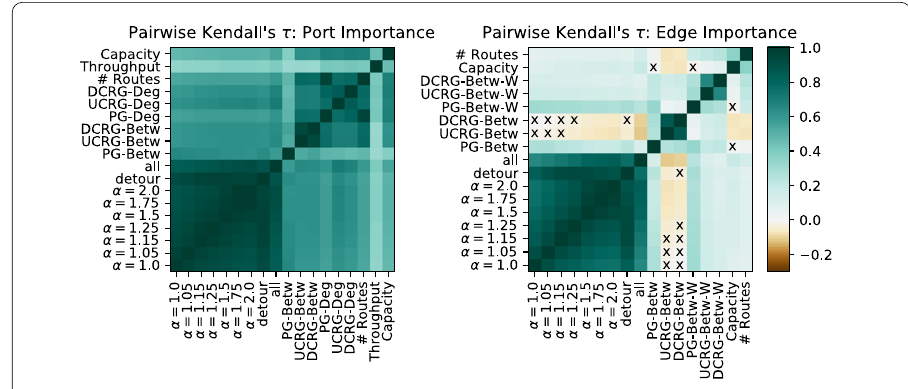
Figure 10 Pairwise Kendall’s τ rank correlation for port rankings between all importance measures for nodes (left) and edges (right). “Capacity” means ranking by the sum of TEU capacity of all routes where a node or edge appears; “# Routes” means ranking by the total number of routes in which the node or edge appears at least once; and “Throughput” means ranking the top 100 ports by container throughput. “DCRG” means directed co-route graph, “UCRG” means undirected co-route graph, and “betw” corresponds to betweenness and “deg” to degree. “all” refers to the full set of minimum-route paths without filtering and “detour” refers to detour factor filtering. Route node and edge betweenness measures correlate strongly across all values of shipping distance filtering threshold α . All pairs of node importance measures have positive correlations. Edge betwenness in the directed and undirected co-route graphs are either neutral or slightly negatively correlated with other edge importance measures. Almost all p-values on the rank correlations coefficients were small; an x indicates that the p-value on the correlation coefficient was not significant at p = 0.01. Note that the correlations are